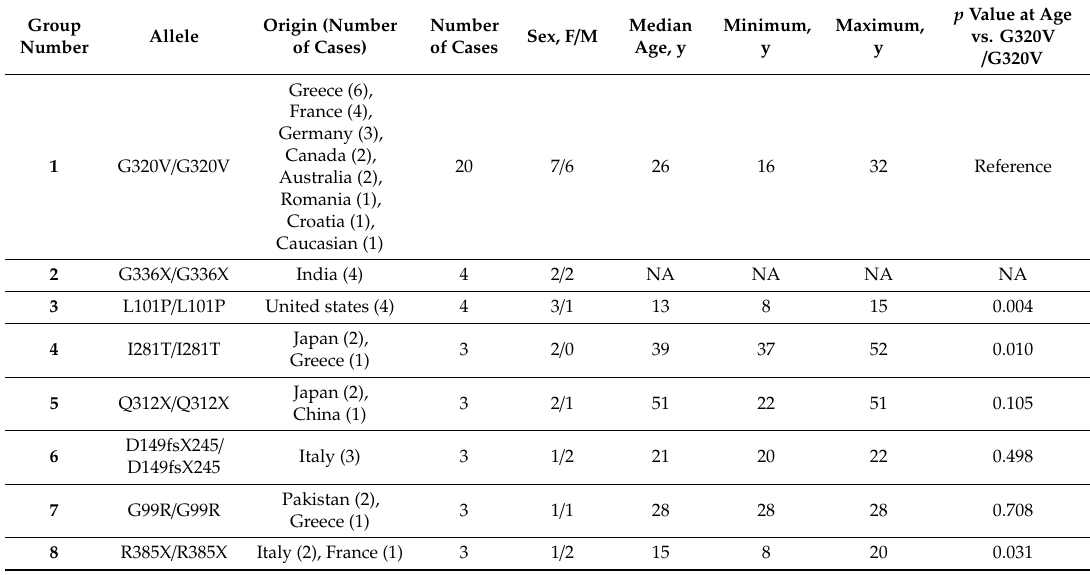
Table 3. Relationship of the HJV mutation with sex and the age of onset in JH patients with homozygous identical mutations in HJV (limited to mutations with ≥ 3 reported